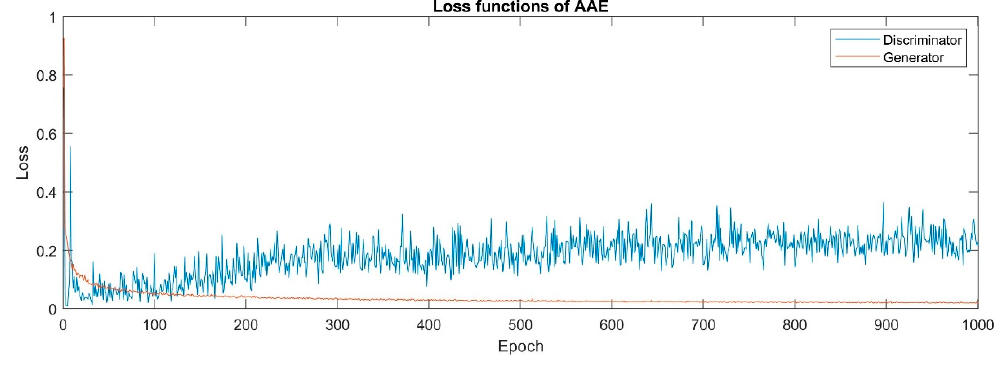
Figure 4. The training process of AAE.